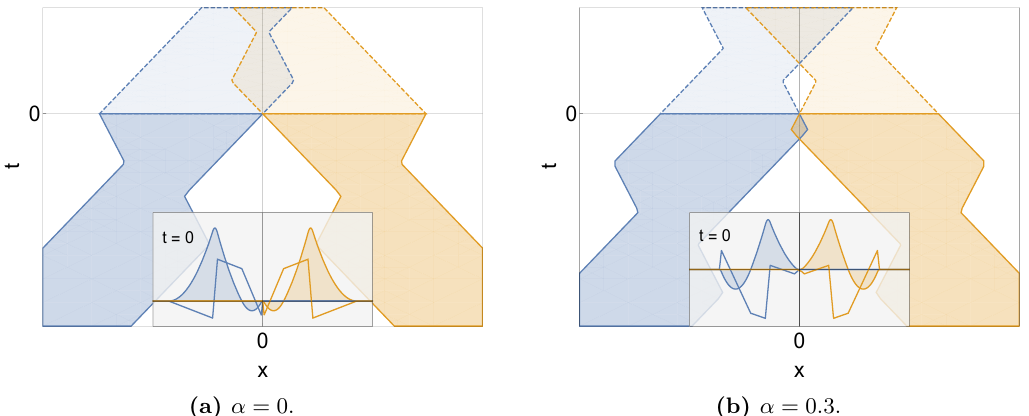
Figure 11 . Symmetric con(cid:12)gurations with v = 0 : 8 and V = 0 : 5 and di(cid:11)erent